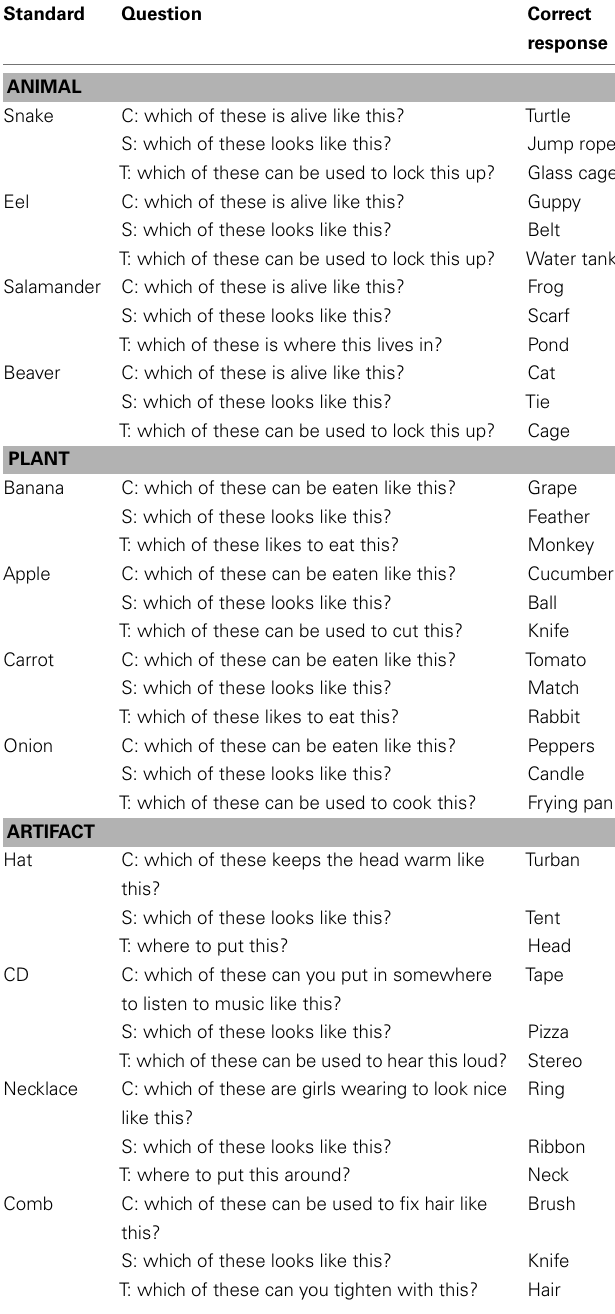
Table 5 | Equally weighted knowledge triggering questions used in Experiment